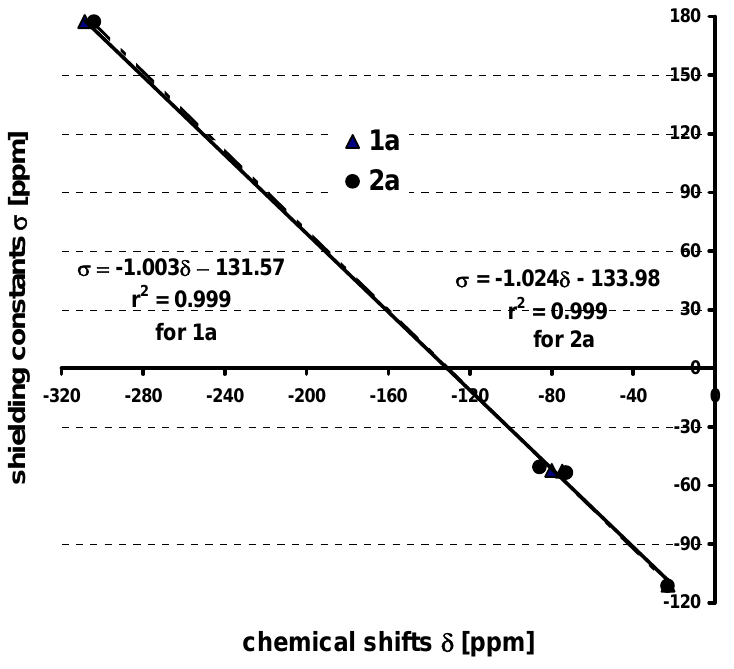
of allyl-( 1 ) and 3-phenylallyl-(5-pyridin–2–yl)- 0